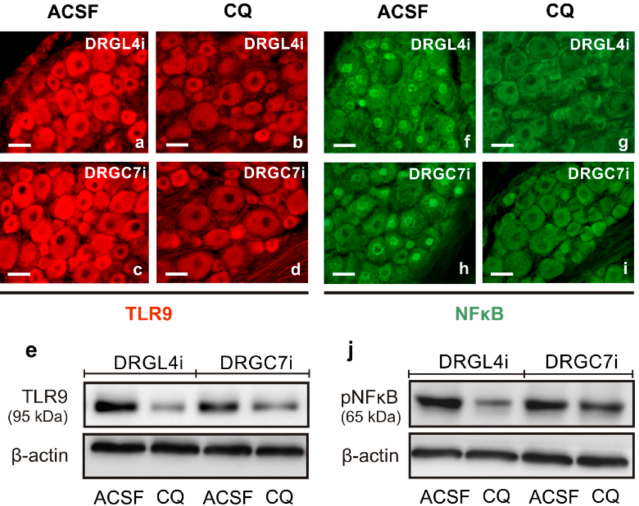
Figure 8. Immunostaining for TLR9 ( a – d ) and pNF κ B ( f – i ) in the lumbar (DRGL4i) and cervical DRG (DRGC7i) ipsilateral to the crushed ulnar nerve in rat with prior CSNT for 7 days and intrathecal application of artificial cerebrospinal fluid (ACSF) or chloroquine (CQ). Sections were immunos- tained with rabbit polyclonal anti-TLR9 or rabbit monoclonal anti-pNF κ B(p65) antibodies and were visualized using TRITC- or FITC-conjugated donkey anti-rabbit secondary antibodies, respectively. Immunostaining demonstrated intense immunofluorescence of both TLR9 and pNF κ B in the DRG neurons of rat treated with ACSF ( a , c , f , h ), but intrathecal application of CQ reduced the intensity of both TLR9 and pNF κ B immunofluorescence ( b , d , g , i ). All sections were processed under the same conditions. Scale bars = 40 µ m. Decreased protein levels of both TLR9 and pNF κ B in the DRGL4i and DRGC7i after CQ application was verified by Western blotting ( e , j ).